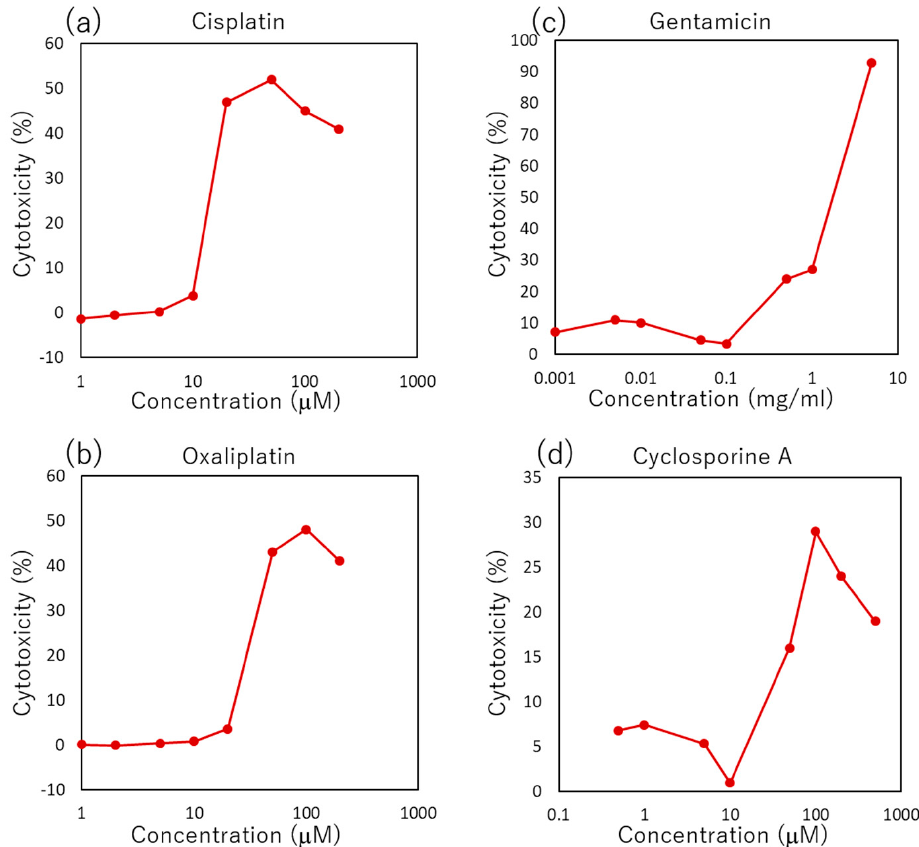
Figure 1. Concentration–cytotoxicity curve measured using the LDH assay kit after 96-h incubation. ( a ) Cisplatin; ( b ) Oxaliplatin; ( c ) Gentamicin; ( d ) Cyclosporine ( a ) Cisplatin; ( b ) Oxaliplatin; ( c ) Gentamicin; ( d ) Cyclosporine A.